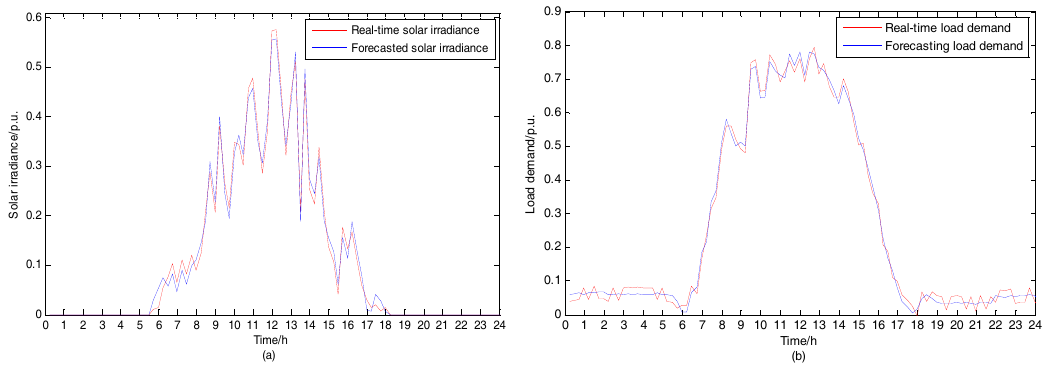
Figure 7. Solar irradiance and load profiles of 16 July 2014: ( a ) Forecasted and real-time solar irradiance; ( b ) Forecasting load demand.